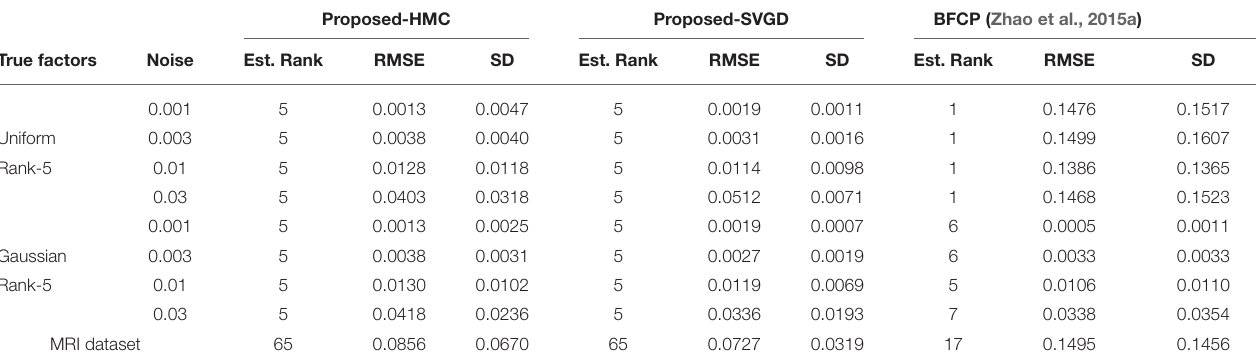
TABLE 2 | Numerical results of tensor completion for the synthetic experiment and MRI dataset.